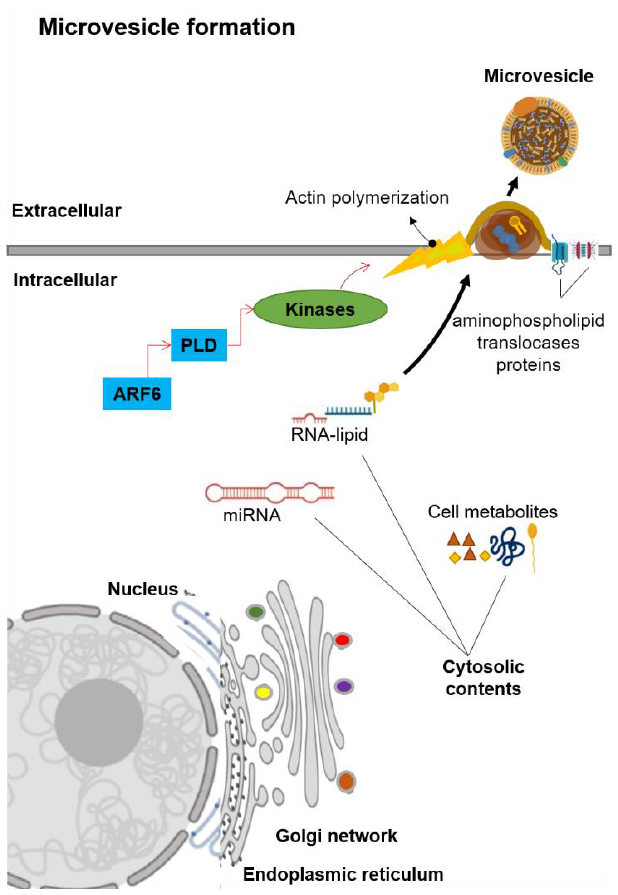
Figure 2. Schematic representation of the microvesicle biogenesis. Abbreviation: ADP-ribosylation factor-6 (ARF6), microRNA (miRNA), phospholipase D (PLD).